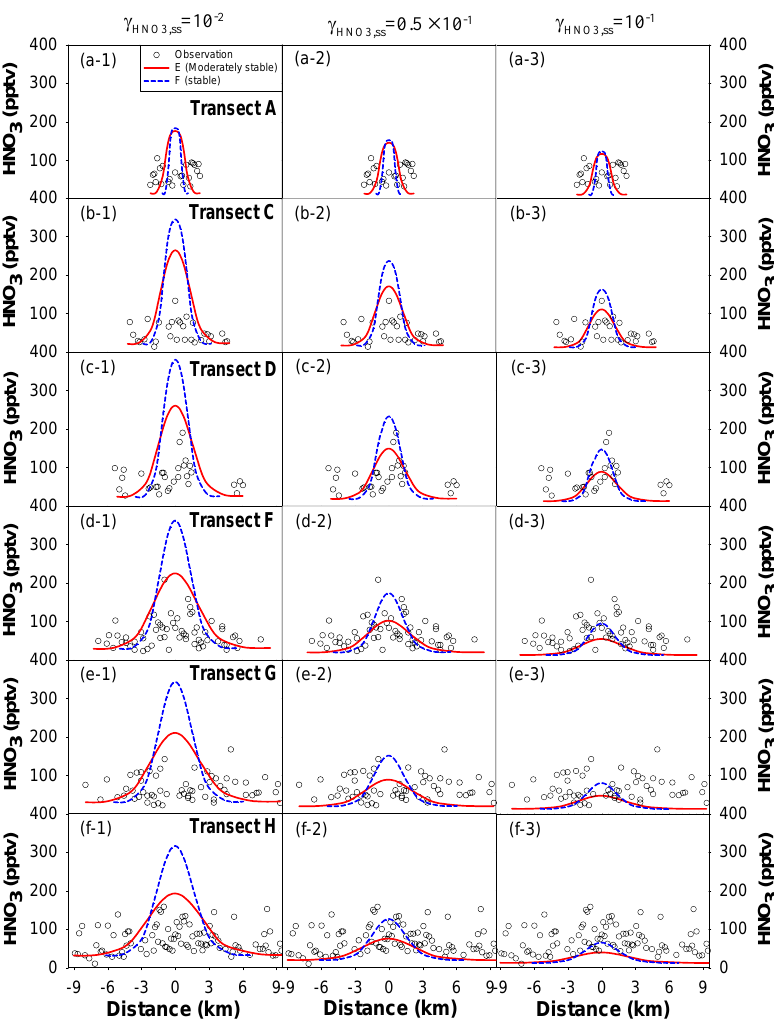
was relaxed from 3 ,ss =10 − 2 , 0.5 × 10 − 1 , and 10 − 1 , respectively, 3 ,ss